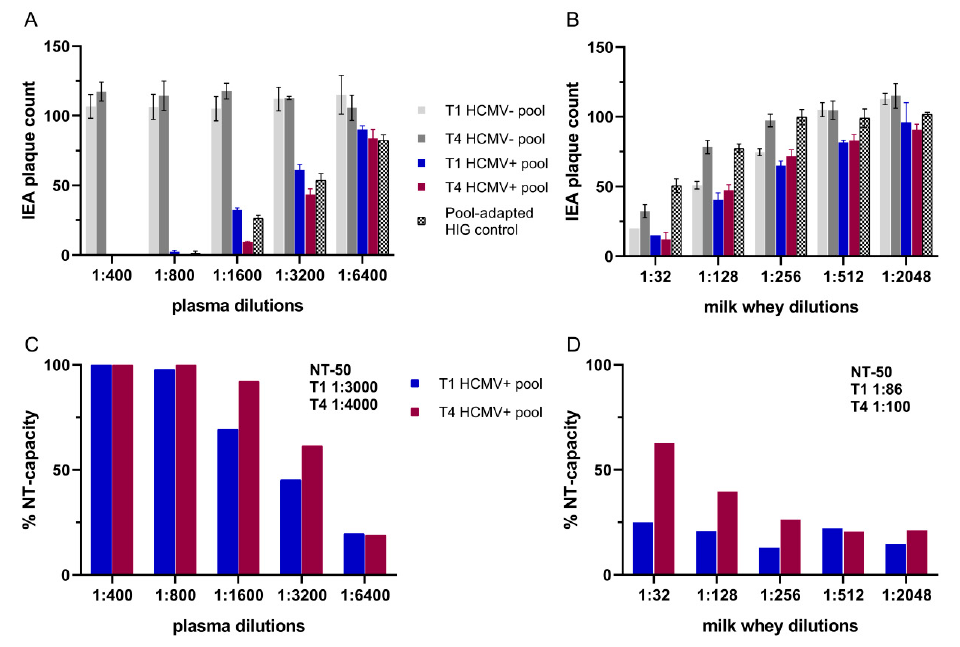
Figure 6. Neutralization assays of HCMV-seropositive and -negative pools using ARPE-19 target cells. ( A ) Plasma and ( B ) whey immediate early antigen (IEA) plaque counts in a two-fold serial dilution (mean + SD). HCMV-IgG calibration using hyperimmunoglobulin (HIG) preparation (prediluted 1:700 to mean ECLIA values of whey and 1:6.5 for plasma values). Neutralization (NT)-capacity in ( C ) plasma and in ( D ) whey were calculated by using the HCMV-seronegative pools as 100% reference for every dilution step. NT-50 values were calculated with a Probit analysis of the seropositive pool with mean values of the seronegative pools as reference.